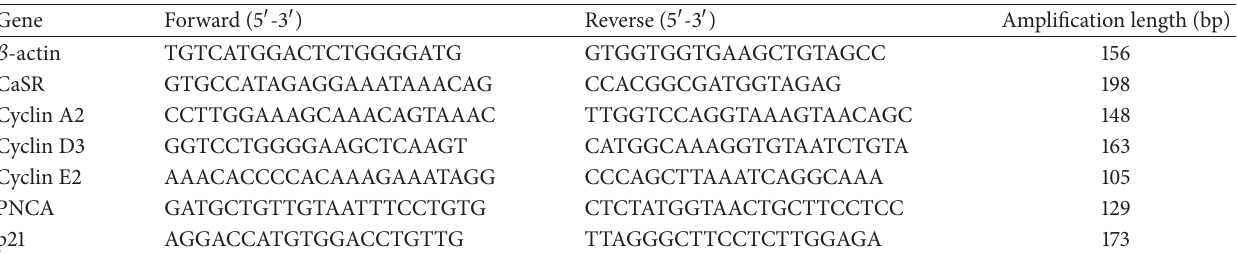
Table 1: The primer sequences used for real-time quantitative